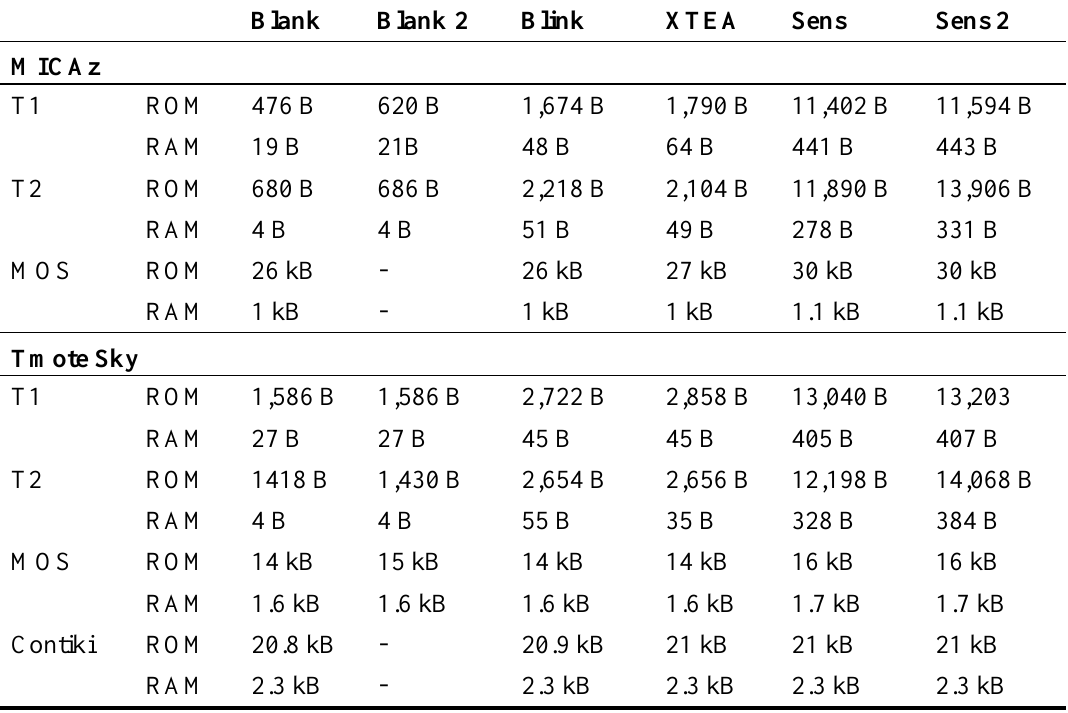
Table 3. MICAz and Tmote Sky program sizes expressed in B (Bytes) or kB (kbytes). Blank Blank 2 Blink